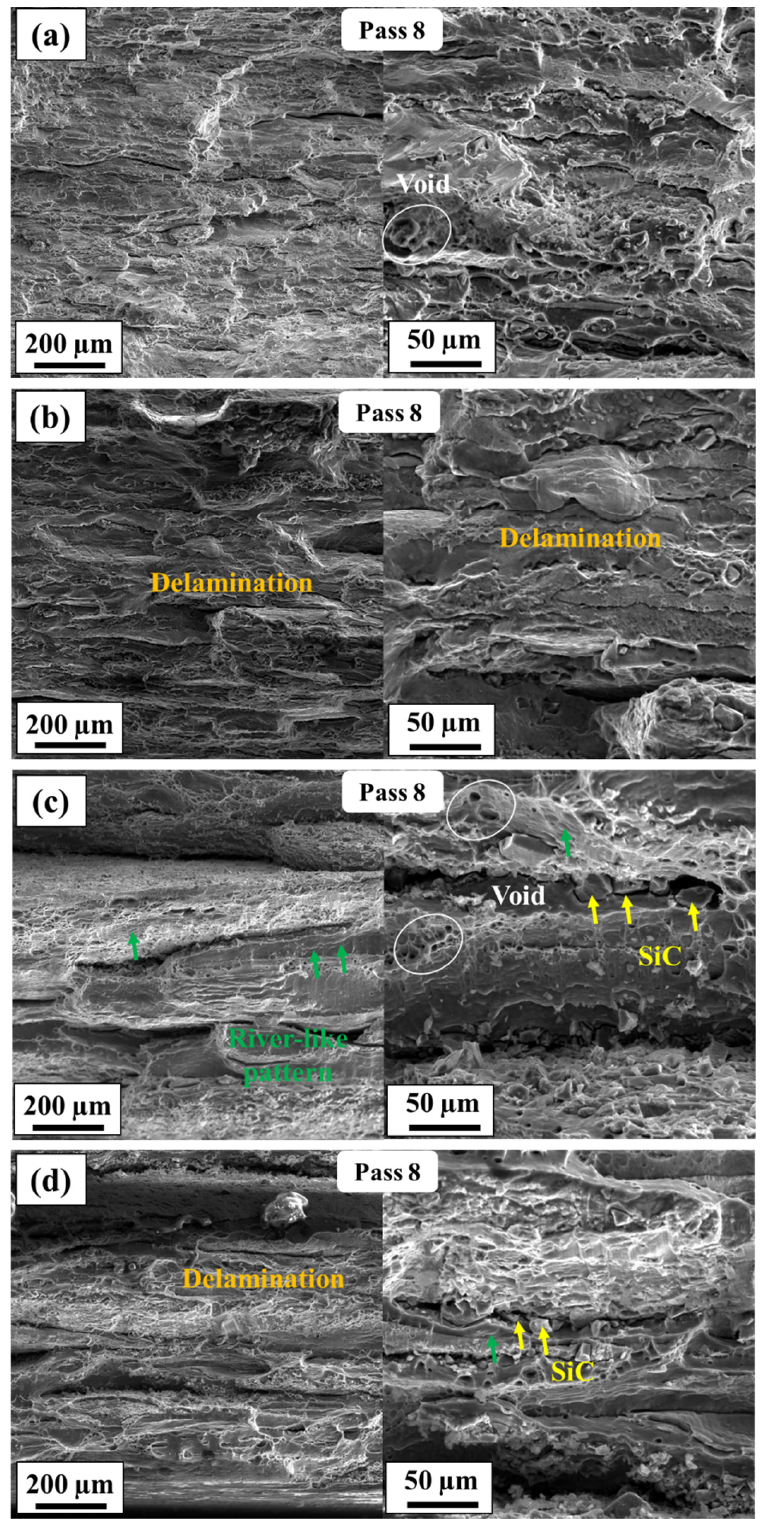
Figure 10. Fracture surfaces of composites fabricated by: ( a ) ARBed Al/Cu/2wt%SiC, ( b ) CARBed Al/Cu/2wt%SiC, ( c ) ARBed Al/Cu/3wt%SiC and ( d ) CARBed Al/Cu/3wt%SiC.